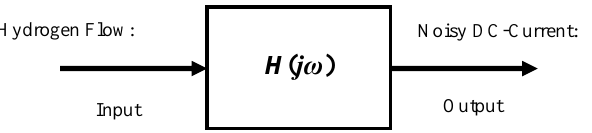
Figure 9: Linear transfer function model of the fuel cell.